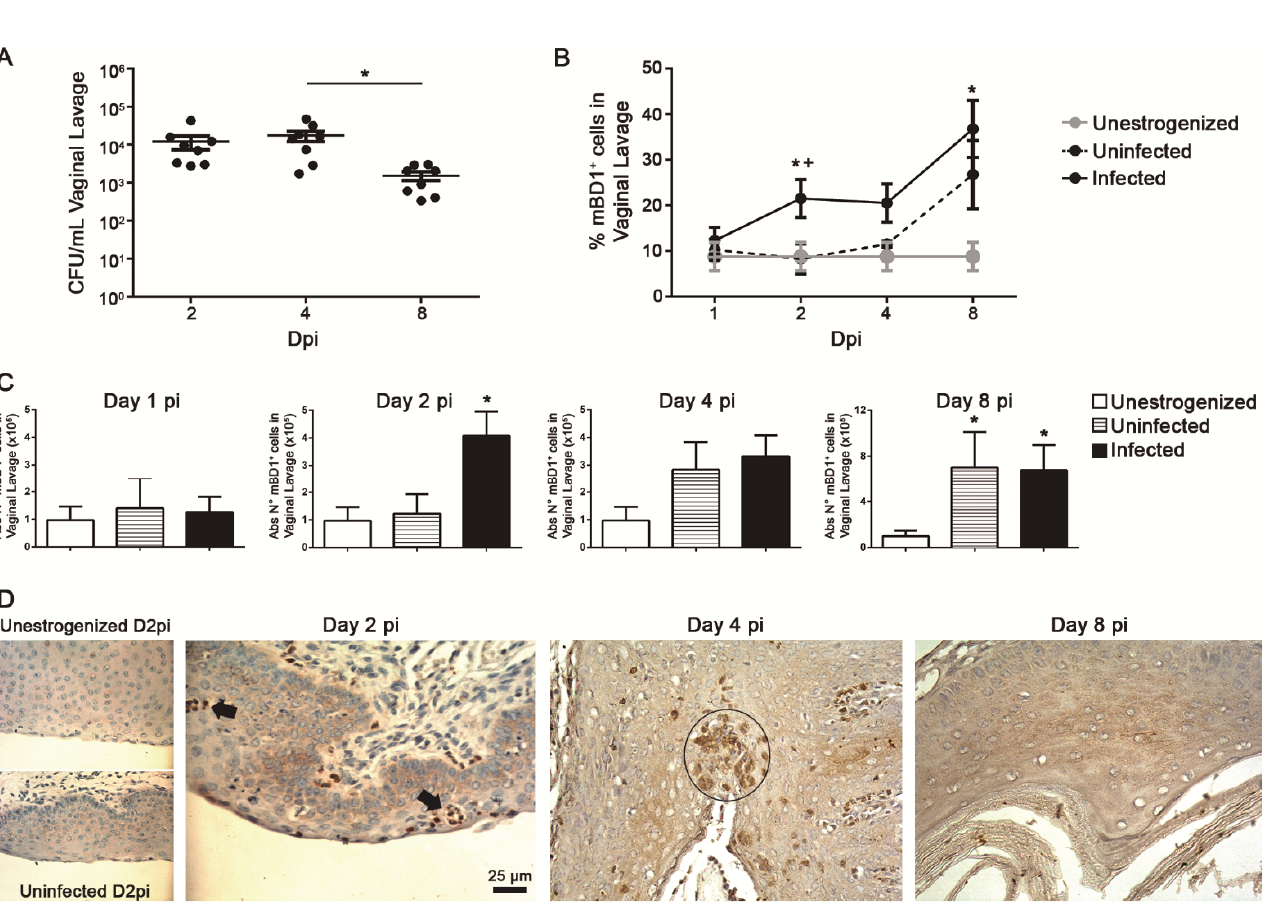
circle indicates the presence of